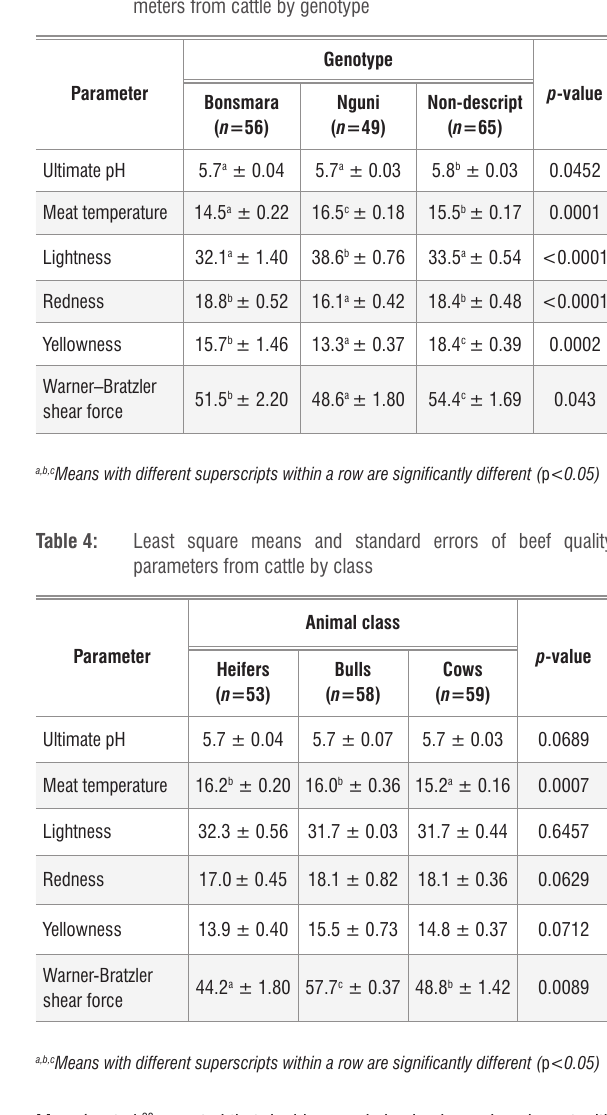
Least square means and standard errors of beef quality para- meters from cattle by genotype